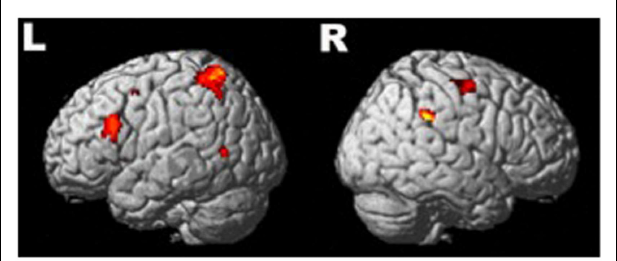
gyrus. Two-sample t-test values refer to tests between controls and stutterers. One-samplet-testsrefertotestsofthewholesample’sLIagainst0(nolaterality). LI varies continuously from − 1 for pure right hemisphere dominance to + 1 for pure left hemisphere dominance.